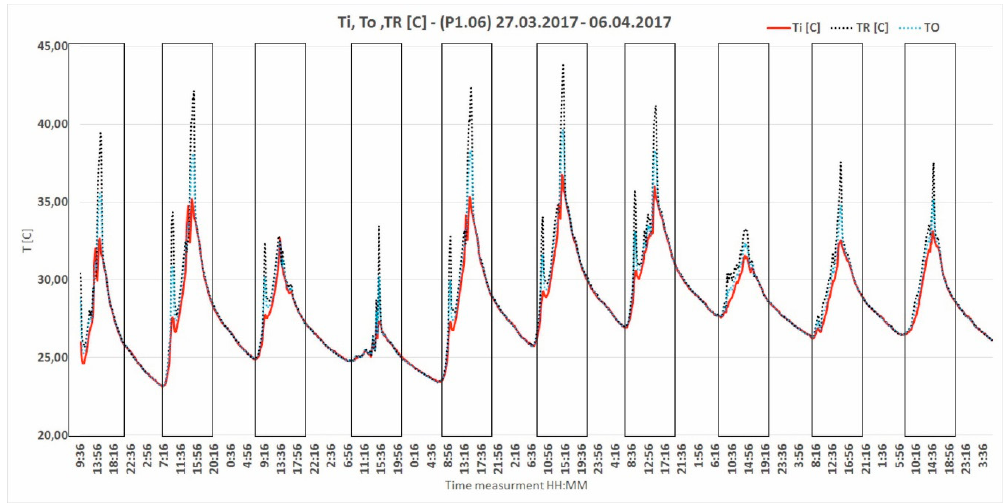
Figure 9. Ambient air temperature ( T i °C) and infrared radiation temperature (TR °C) in room P1.06.